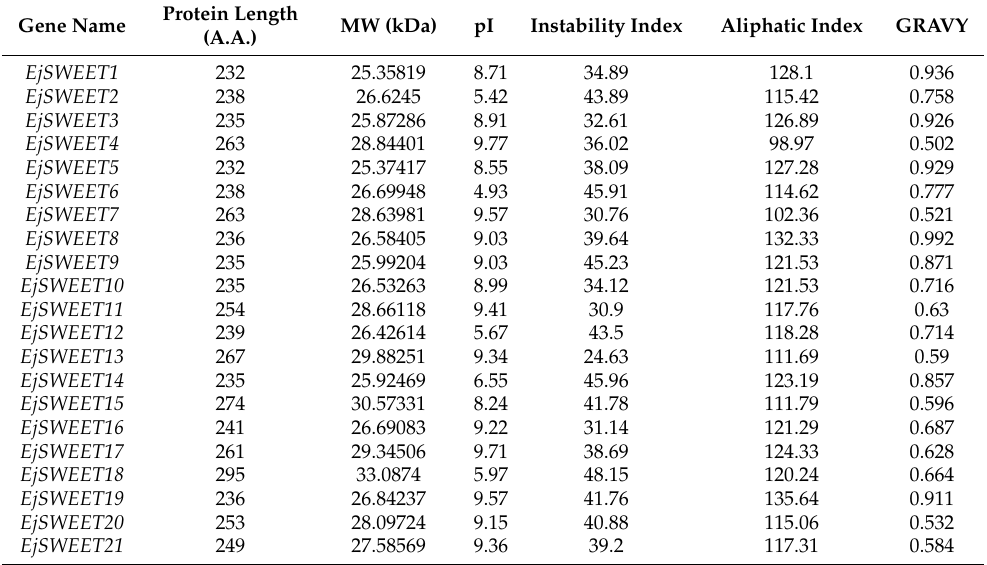
Table 3. Summary information of physicochemical properties of the SWEET proteins in